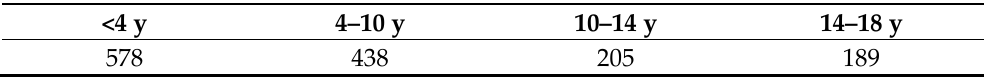
Figure 1. Age distribution of patients.